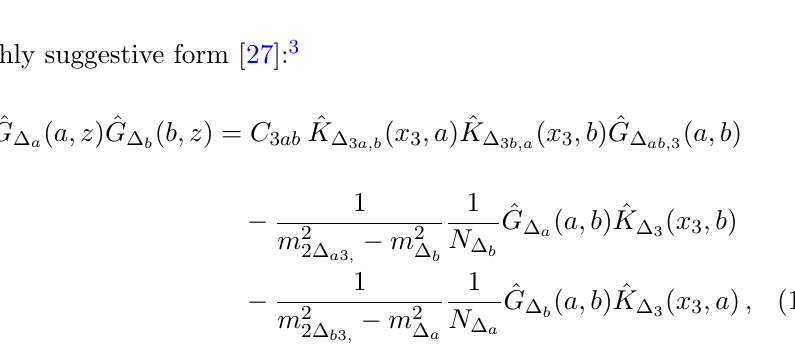
Figure 4 . The (cid:12)ve-point geodesic bulk diagram on the Bruhat-Tits tree dual to the (cid:12)ve-point p -adic conformal partial wave